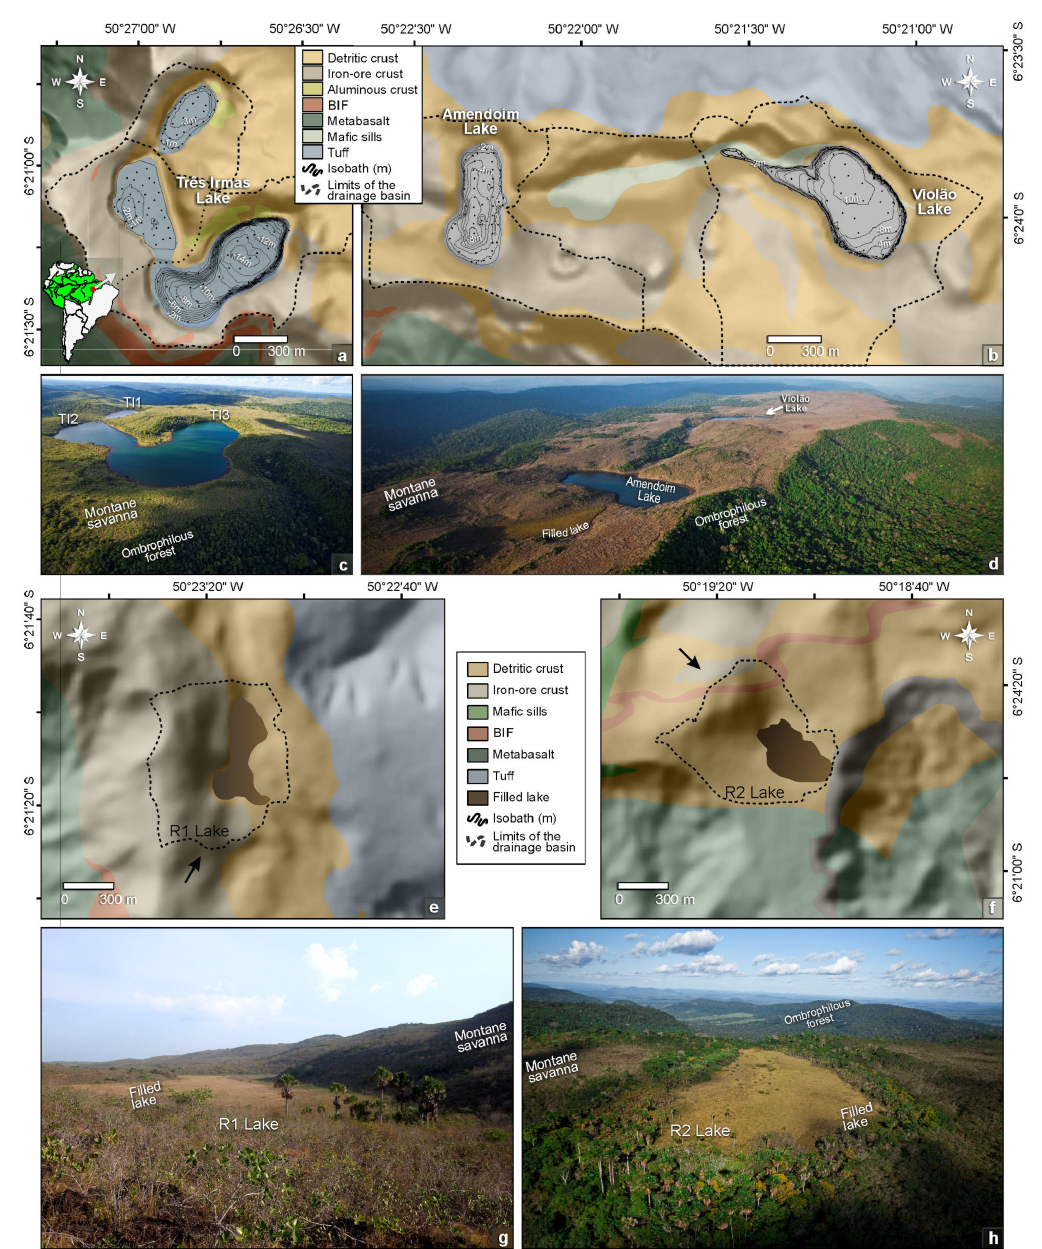
Figure 3. ( a , b ) Digital elevation model (DEM) integrated with bathymetric data showing the western and eastern portions of the Serra Sul Plateau and the main lithotypes described in the catchment basins of active ULs [25]. Aerial photograph of ( c ) Tr ê s Irm ã s (TI1, TI2 and TI3), ( d ) Amendoim (AM) and Viol ã o lakes (VL). ( e , f ) DEM showing the main lithotypes described in the catchment basins of filled ULs, also a detail (black arrow) for the direction of view of photo ( e , f ). ( g , h ) Aerial photograph of the filled